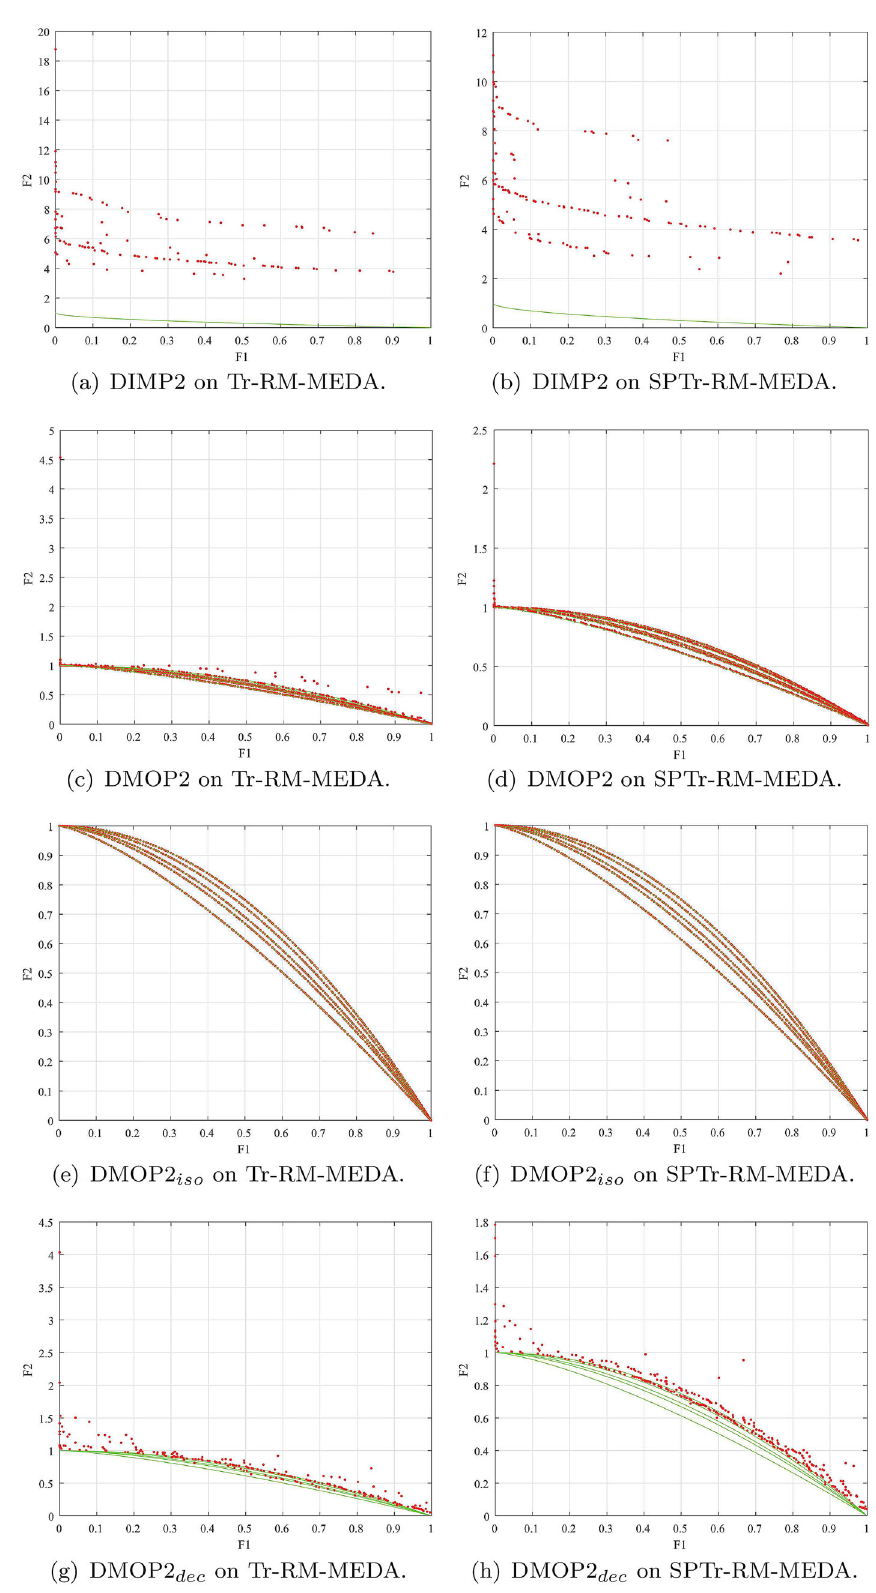
Fig. 2 Comparative PFs on different environments (T=5, 10, 15, 18, and 20 for two-objective problems under